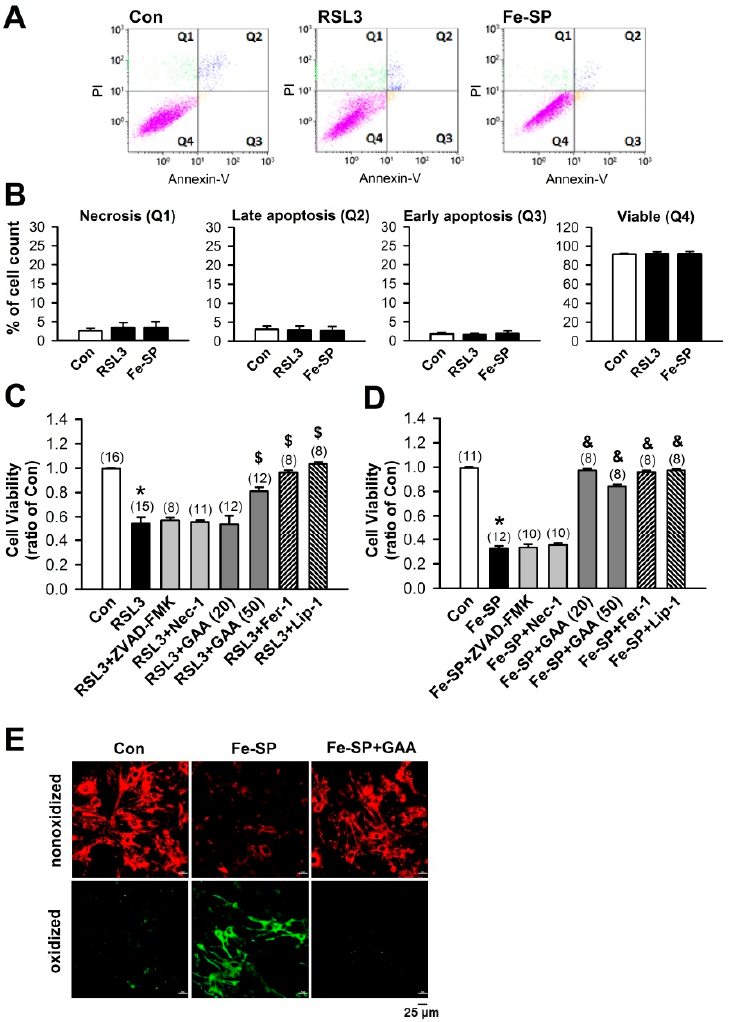
Figure 5. GAA protects against ferroptotic cell death and inhibits lipid peroxidation in neonatal rat cardiomyocytes. ( A ) RSL3 and Fe-SP did not induce apoptosis and necrosis according to analysis by flow cytometry of Annexin V-FITC/PI double staining at 24 h. ( B ) Statistical analysis of necrosis (Q1), late apoptosis (Q2), early apoptosis (Q3), and viability (Q4) in neonatal rat cardiomyocytes (n = 4). ( C ) MTT results showing a significant decrease in cell viability 24 h postexposure to 0.5- µ M RSL3, abolished by GAA (20–50 µ M), Fer-1 (1 µ M), and Lip-1 (2 µ M), but not ZVAD-FMK (10 µ M) or Nec-1 (10 µ M). Values shown in parenthesis represent the number in each group. In each group, 2 to 3 samples were analyzed, and the same experiment was assessed by repeating cell culture four times or more. ( D ) MTT results showing a significant decrease in cell viability 24 h postexposure to 2- µ M Fe-SP, abolished by GAA (50 µ M), Fer-1 (1 µ M), and Lip-1 (2 µ M), but not ZVAD-FMK (10 µ M) or Nec-1 (10 µ M). Values shown in parenthesis represent the number in each group. In each group, 2 to 3 samples were analyzed, and the same experiment was assessed by repeating cell culture four times or more. ( E ) Confocal images of neonatal rat cardiomyocytes treated with Fe-SP (2 µ M) for 2 h; a significant increase in levels of lipid peroxidation was observed (green), but this effect was abolished by 50- µ M GAA. Red, nonoxidized form of C11 BODIPY; Green, oxidized form of C11 BODIPY. Scale bars: 25 µ m. All data represent means ± SEM. * p < 0.05 versus the control group; $ p < 0.05 versus RSL3; & p < 0.05 versus Fe-SP. Con, control; Fer-1, ferrostatin-1; Lip-1, liproxstatin-1; RSL3, (1S,3R)-RSL3; Fe-SP, chlorido [N, N-disalicylidene-1,2-phenylenediamine] iron (III); GAA, gossypol acetic acid; Nec-1, necrostatin-1.